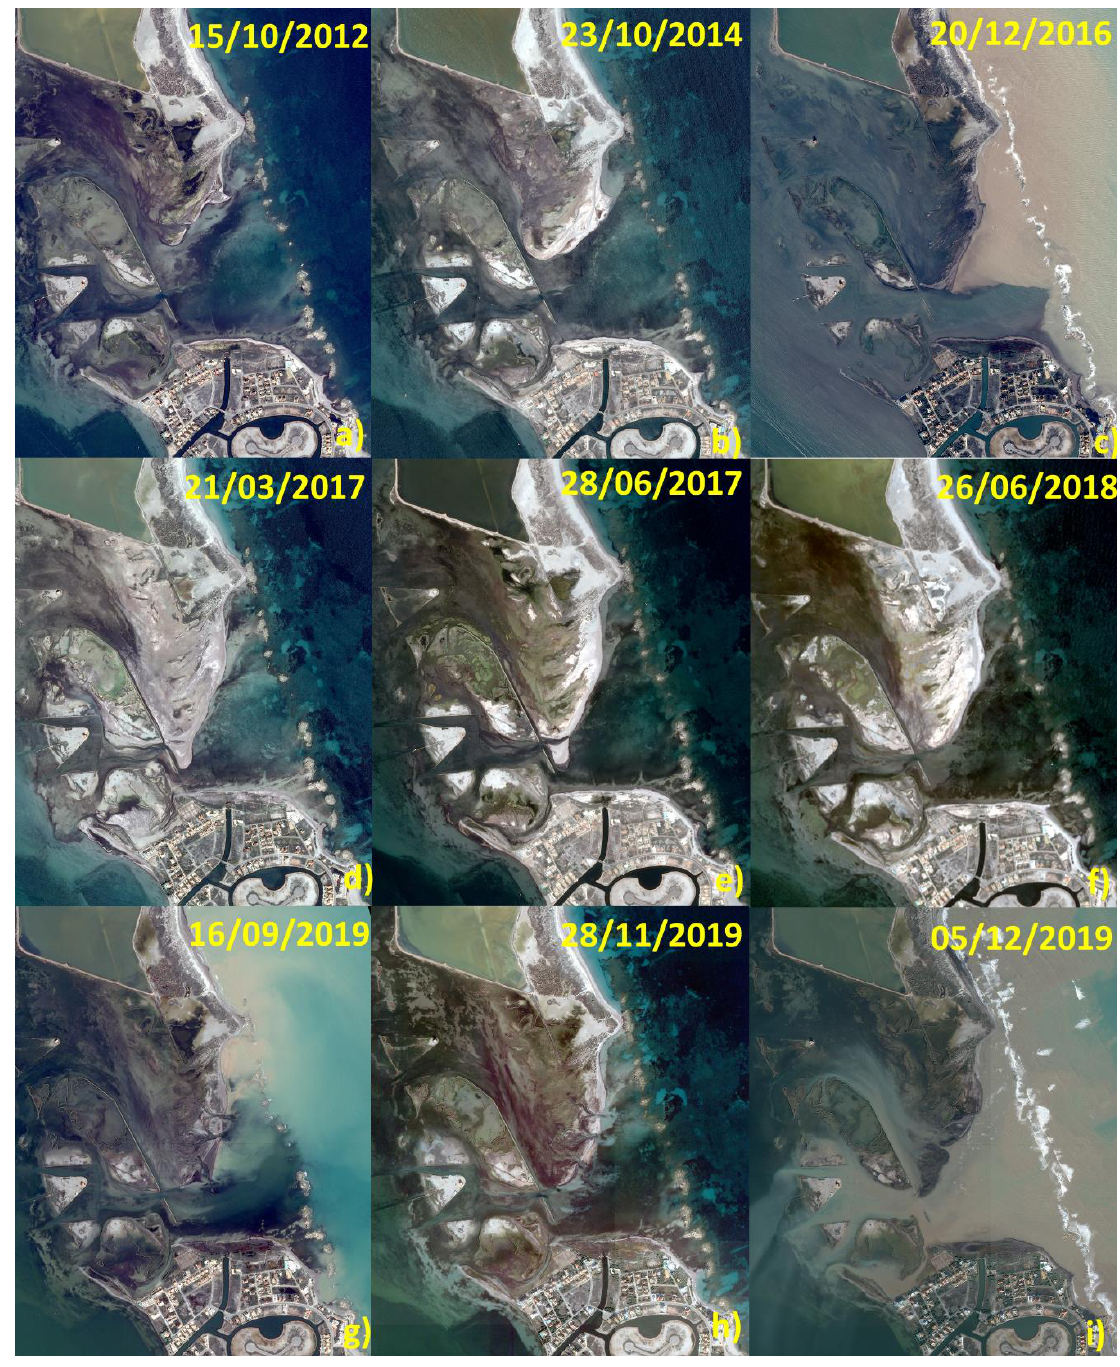
Figure A1. Pleiades images time series of the study: ( a ) First image available (15 October 2012); ( b ) The sediment accumulation process is evident; ( c ) During the first cut-off lows (CoLs); ( d ) Sediment accumulation process after the first CoLs; ( e ) Start of depth restoration; ( f ) Final of depth restoration; ( g ) During the second CoLs; ( h ) Sediment accumulation process after the second CoLs; ( i ) During the third CoLs (5 December 2019).